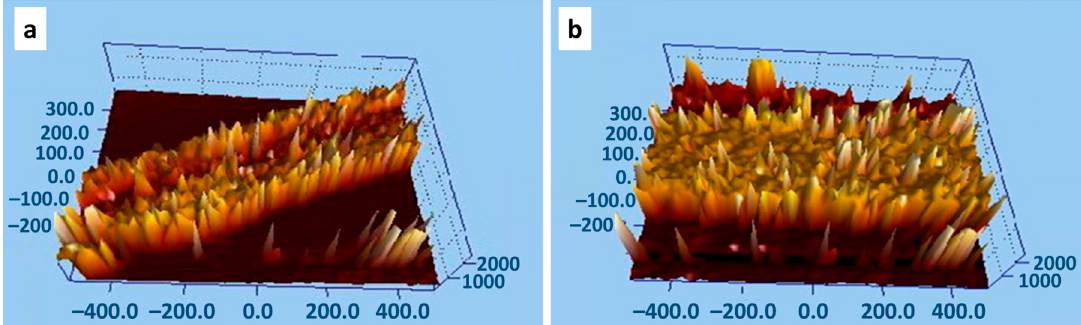
Figure 3. Roughness images: ( a ) BTF and ( b ) SACCMDBTF.